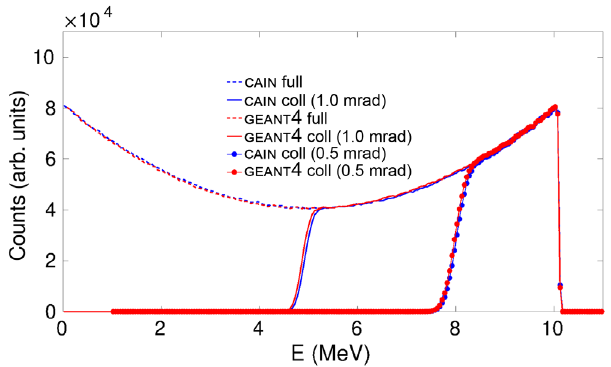
FIG. 4. Full and collimated spectrum of the EGammaS-GBS photon beam simulated with CAIN and GEANT 4 .